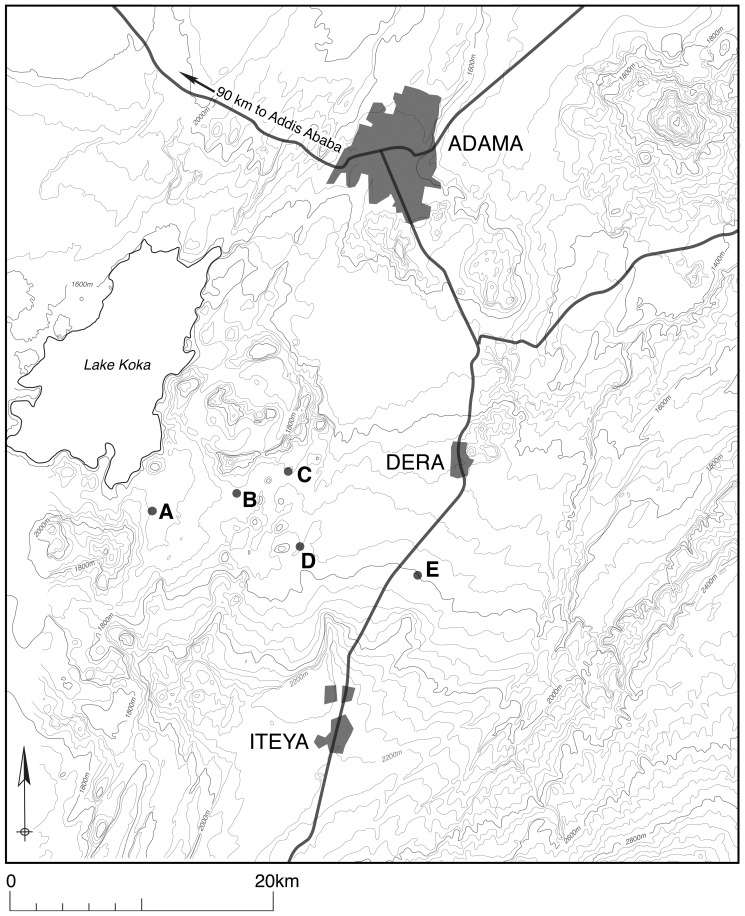
Map of study site.